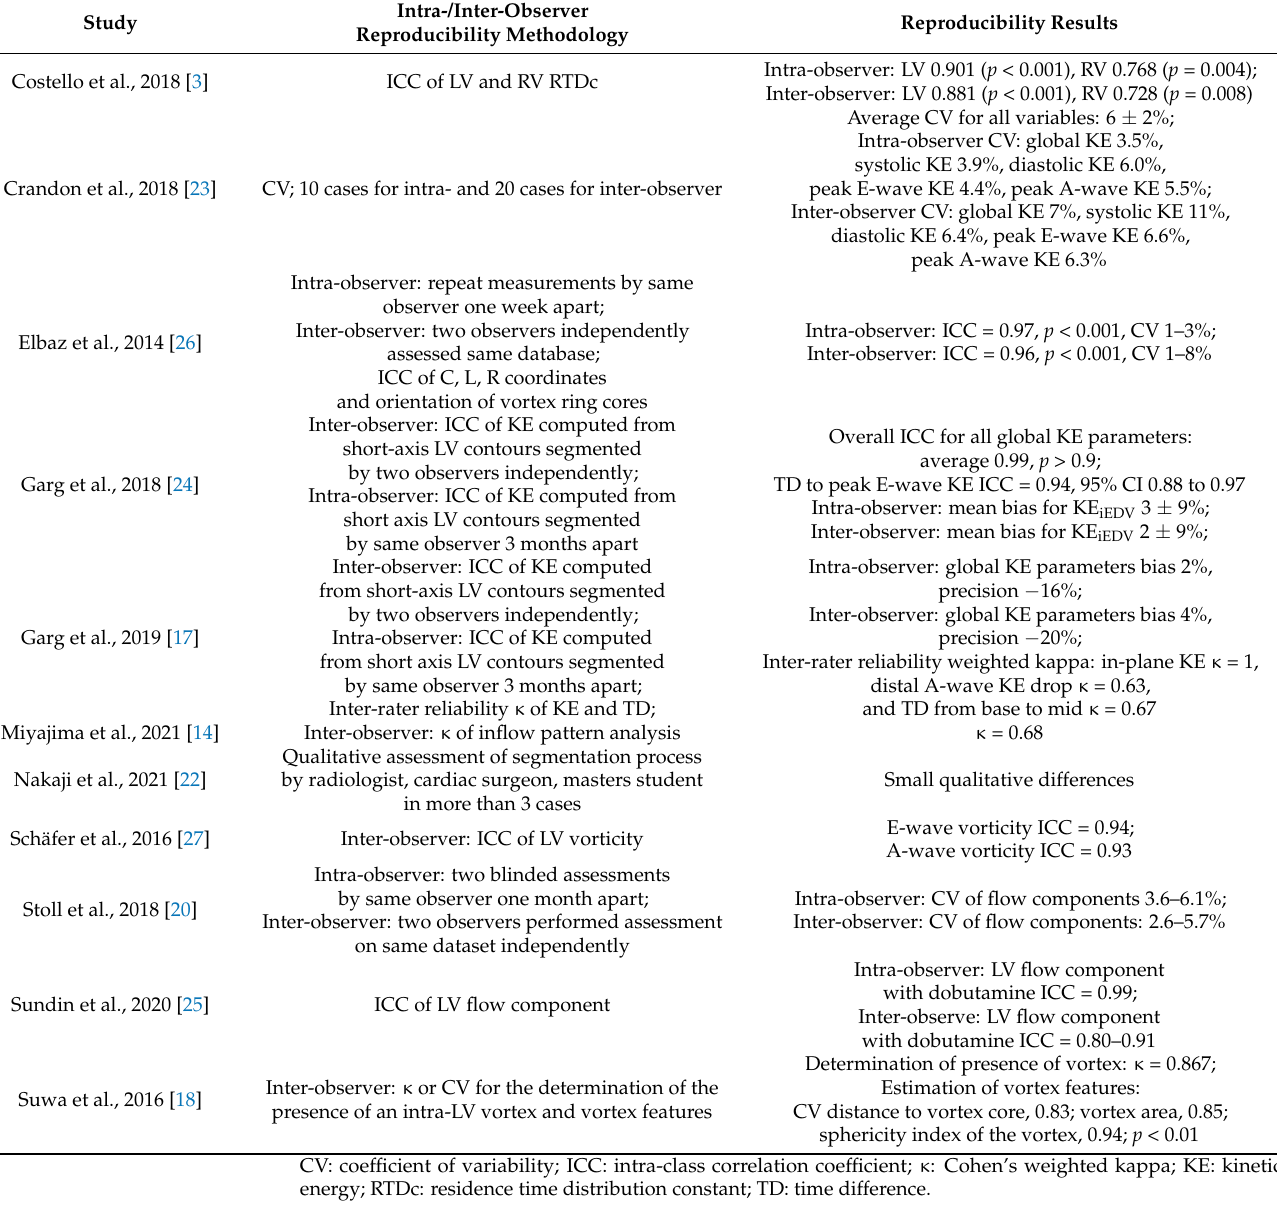
Table 1. Intra-/inter-observer reproducibility methodologies and